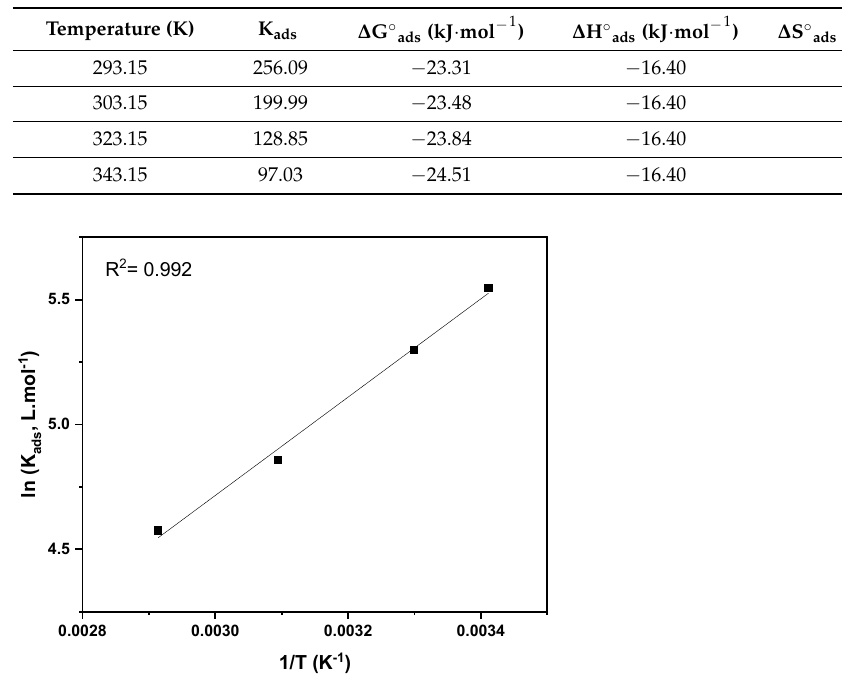
Figure 7. Van’t Hoff plot for adsorption of Q-22 inhibitor in 5 M HCl onto C-steel at 20, 30, 50, and 70 °C.